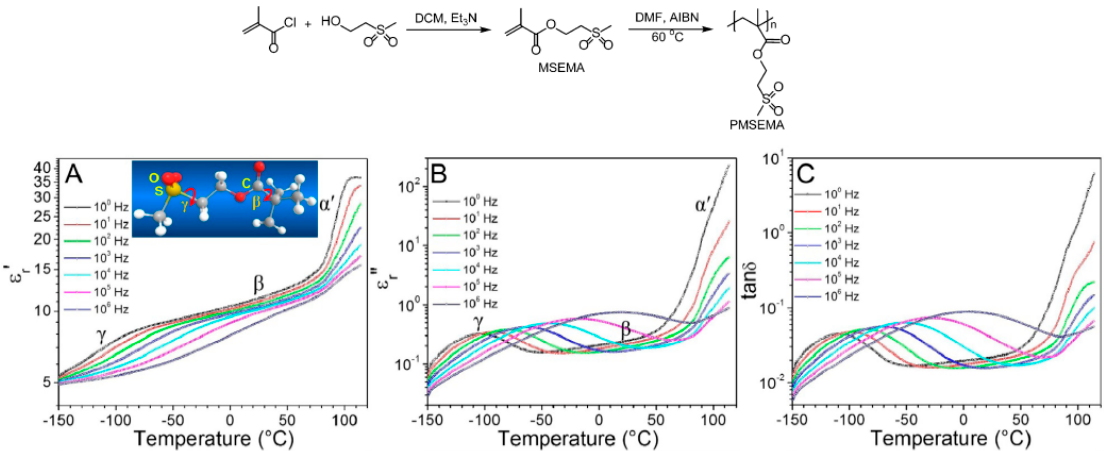
Figure 5. A ) Real ( ε′ r ) and B ) imaginary ( ε″ r ) parts of the relative permittivities and C ) dissipation factors (tan δ ) as a function of temperature at different frequencies for PMSEMA. Adapted from reference [11] with permission. Copyright 2015, American Chemical Society.